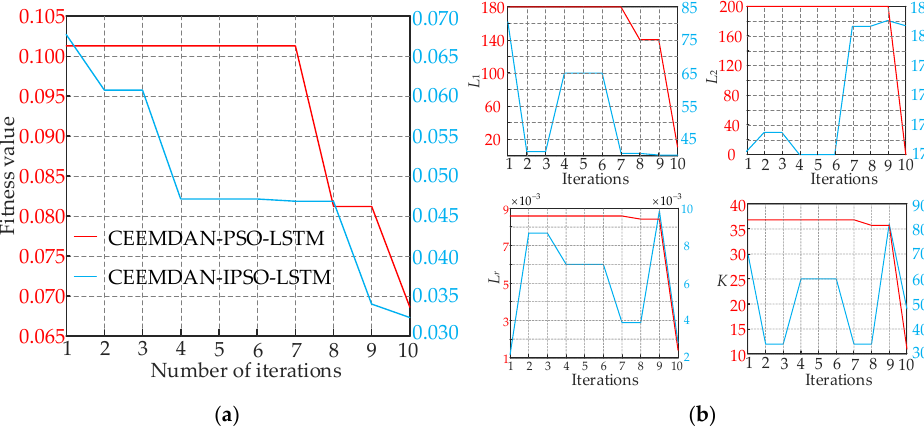
Figure 6. ( a ) The error convergence curves of CEEMDAN ‐ PSO ‐ LSTM model and CEEMDAN ‐ IPSO ‐ LSTM model in the training process. ( b ) The hyperparameters optimization results of CEEMDAN ‐ PSO ‐ LSTM model and CEEMDAN ‐ IPSO ‐ LSTM model. The LSTM, CEEMDAN ‐ LSTM, and CEEMDAN ‐ PSO ‐ LSTM models were employed for comparison testing to confirm the accuracy of the proposed CEEMDAN ‐ IPSO ‐ LSTM model. Figure 7 displays the outcomes of several model predictions of data on the in ‐ bound and outgoing passenger flow. As can be observed, the trend of the actual value curves, whether during the peak time or off ‐ peak period, is largely consistent with the forecast curves derived by various models. The CEEMDAN ‐ IPSO ‐ LSTM model, on the other hand, correlates to a prediction curve through thorough local observation, which has greater forecast accuracy than the other models and is more similar to the real moni ‐ toring curve, indicating the CEEMDAN ‐ IPSO ‐ LSTM model has strong robustness.